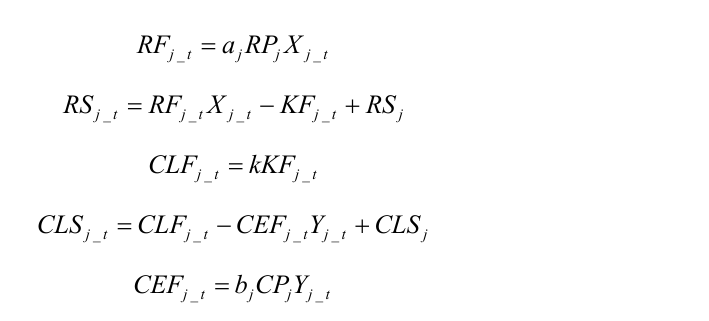
Figure 6. The diagram of flows and stocks in relation to AS in cement j